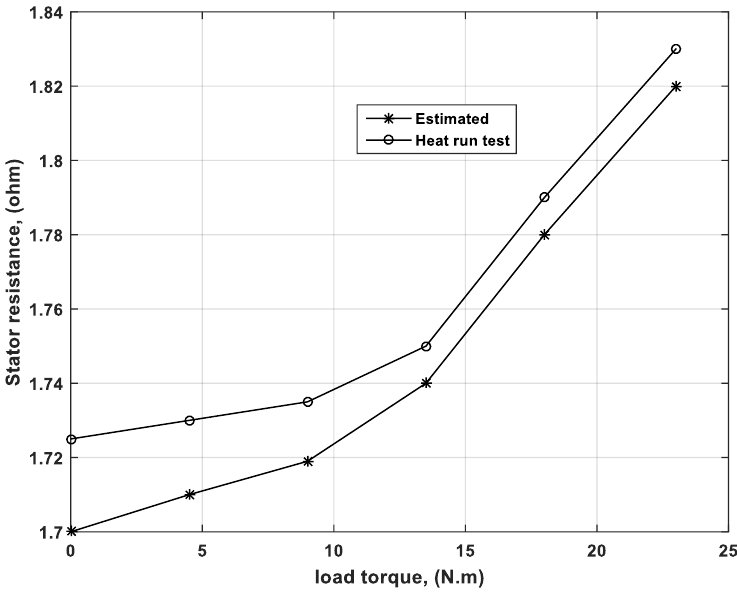
Figure 13. Stator resistance versus load torque at heat run test.